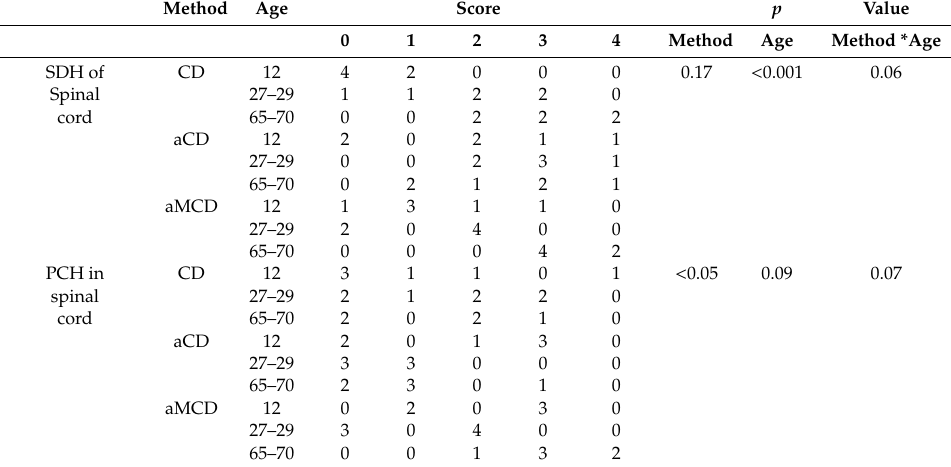
Table 12. Overall summary of microscopic scoring of subdural hemorrhage and parenchymal hemorrhage in the spinal cord of layer chickens killed by three killing methods. Number of birds with each score are